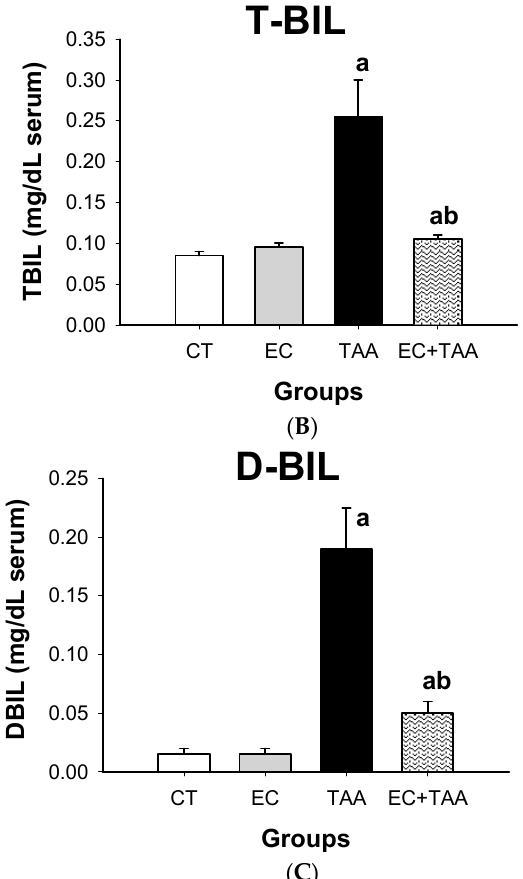
Figure 3. Effect of EC pretreatment on levels of ( A ) ALP, ( B ) T-Bil, and ( C ) D-Bil analyzed by Wiener Lab equipment in the serum of rats intoxicated with a sublethal dose of thioacetamide (TAA). In ALP, the results are expressed in U/L, while T-Bil and D-Bil are expressed in mg/dL of serum. Bars indicate the mean value with the SE of two determinations (n = 8). The differences compared with the vehicle are expressed as “ a ”; while the differences due to TAA are expressed as “ b ”, p ≤ 0.05.